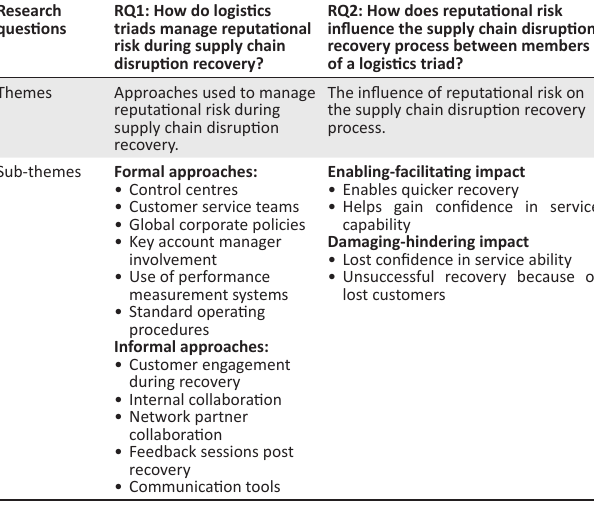
TABLE 2: Summary of themes, sub-themes and codes. Research